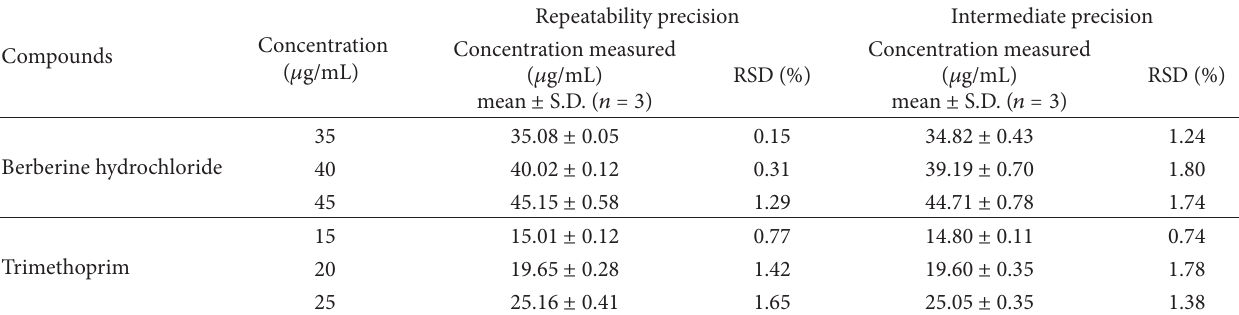
T 1: Repeatability and intermediate precision data of proposed method.